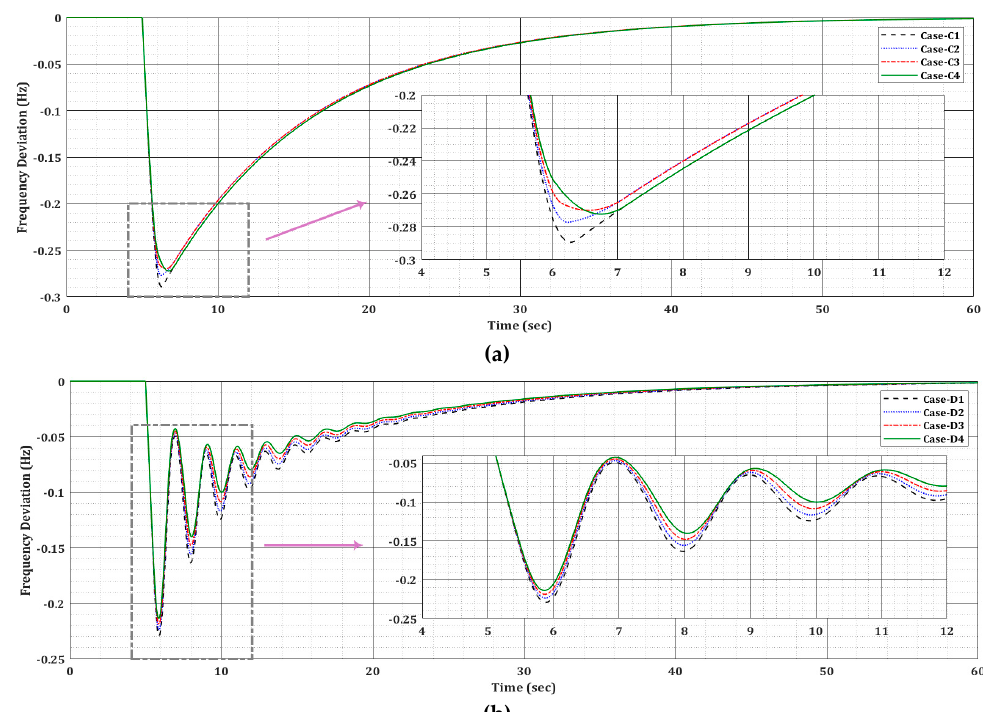
Figure 6. Frequency response under load disturbance when the test system has responsive loads ( a ) frequency deviation for single-machine and responsive loads cases (C1-C4); ( b ) frequency deviation for single-machine and responsive loads cases (D1-D4).